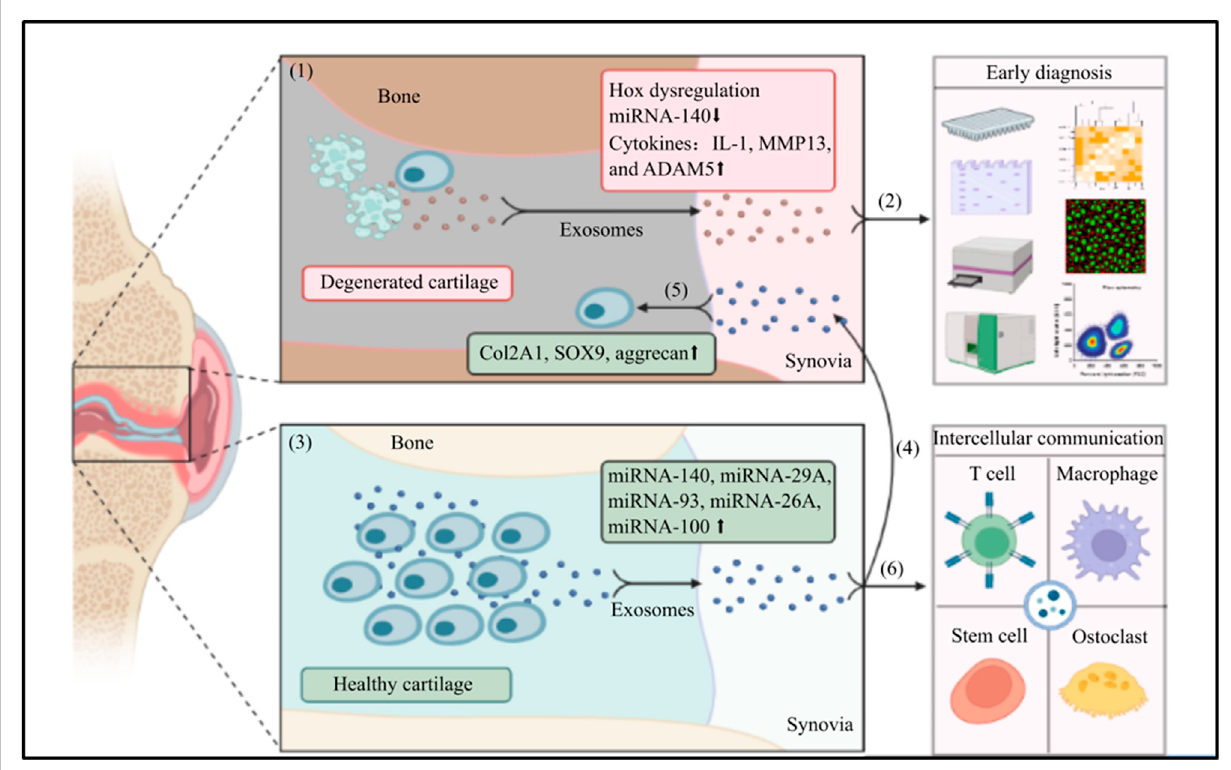
The application of exosomes in the early diagnosis and treatment for OA: (1) In an OA joint, chondrocytes undergo apoptosis, the structure of cartilage is damaged. Chondrocytes and mesenchymal stem cells in the OA environment intend to secrete exosomes with Hox gene dysregulation, low expression of miRNA-140, and high levels of IL-1, MMP13 and ADAM5; (2) The exosomes are secreted into synovial fl uid that can be harvested in a minimally invasive way, the speci fi c phenotype or enveloped component of exosomes are sensitive markers to early diagnose OA and differentiate the pathological stages; (3) In contrast, chondrocytes and mesenchymal stem cells in a healthy joint can secrete exosomes with high expression of various miRNA;(4)Theexosomes withspeci fi cmiRNAsaresecreted intothesynovial fl uid;(5)Thesynovial fl uidderived-exosomes canbeharvested and injectedintoaOAjoint,thewrappedfunctionalmiRNAs canincreasethelevelsofCol2A1,SOX9, and aggrecan, topromotetheregenerationofcartilage and reverse the progression of OA; (6) Meanwhile, the synovial fl uid derived-exosomes can also involve in a intercellular communication with many neighboring cells, e.g., T cell, macrophage, osteoclast, and stem cell to multidimensionally protect the joint harmed by OA. (The graphic components of this illustrative scheme were provided by